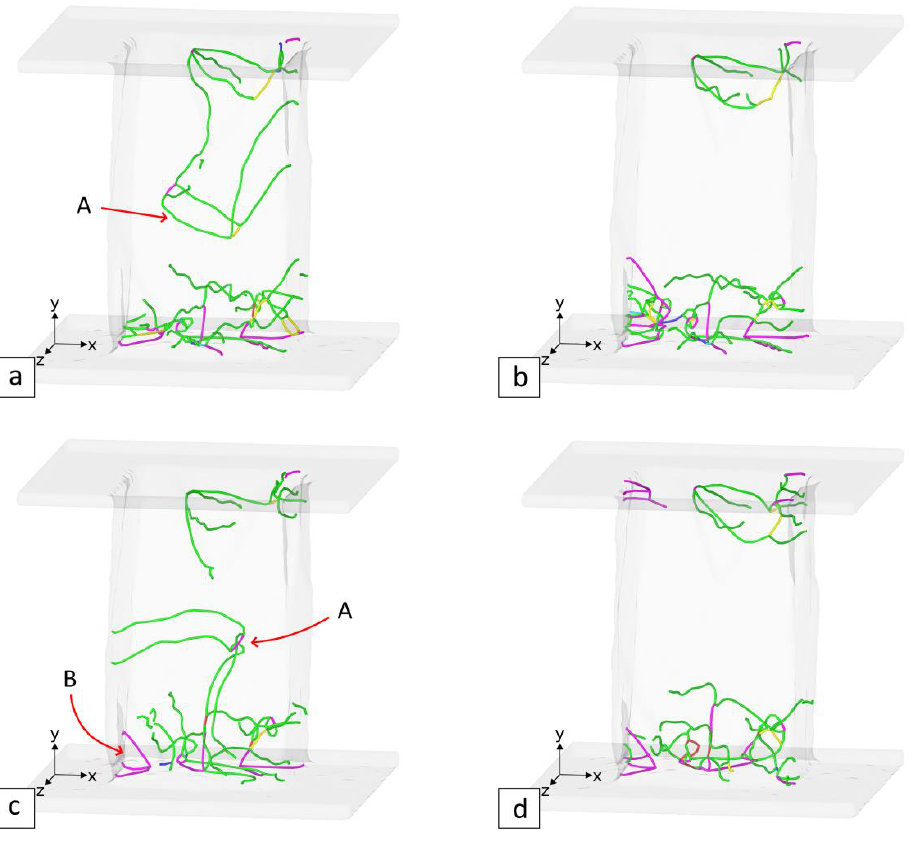
Figure 4. The evolution of the dislocation structure of CuAl alloy single crystal at strain: ( a ) 10.1%; ( b ) 10.6%; ( c ) 11.3%; and ( d ) 12.3%.